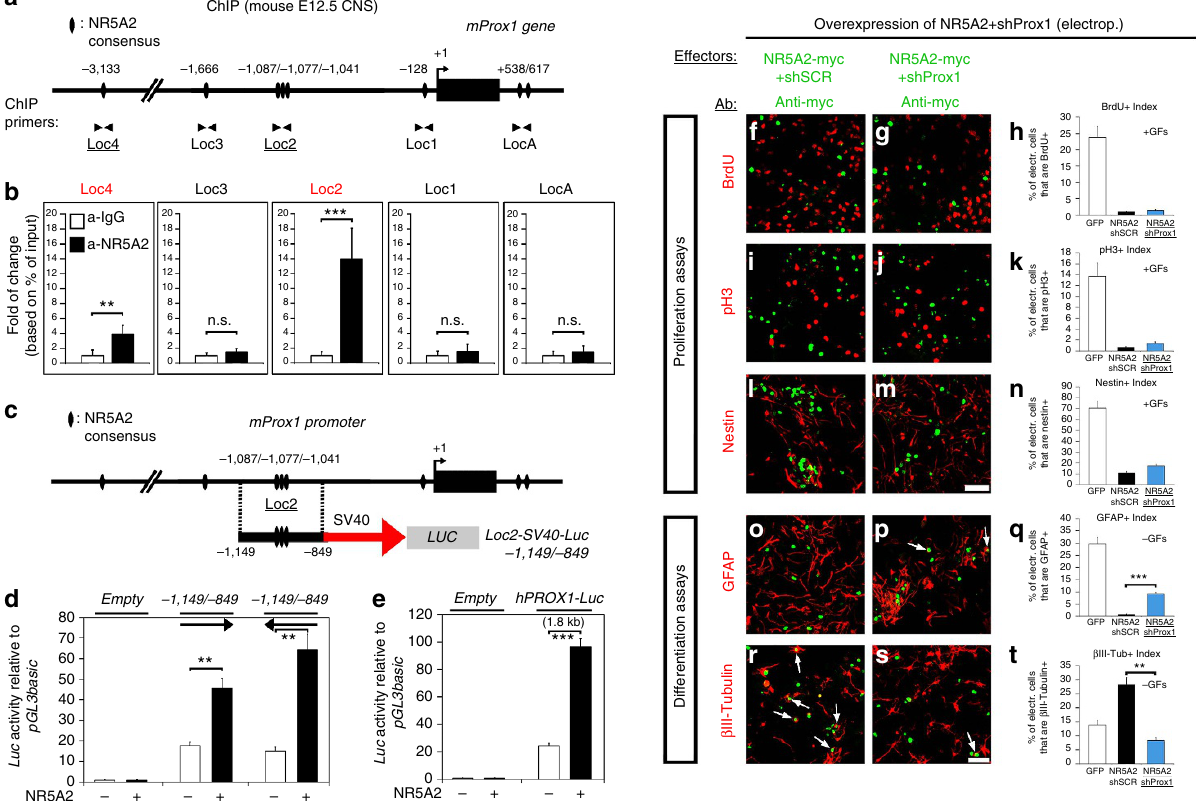
Figure 7 | NR5A2 regulates Prox1 expression via direct activation of Prox1 promoter. ( a ) Schematic representation of mouse Prox1 gene locus. ( b ) ChIP analysis for the binding of NR5A2 to Prox1 gene in chromatin prepared from the CNS of E12.5 mouse embryos. ( c ) Schematic representation of the luciferase-reporter constructs containing the mouse DNA sequence of Loc2 ( (cid:2) 1,149/ (cid:2) 849) in both orientations ( Loc2-SV40-Luc ( (cid:2) 1,149/ (cid:2) 849 ) - / ’ ). ( d , e ) Transcriptional assays in N2A neuroblastoma cells with mouse ( d ) or human ( e ) Prox1 promoter constructs, as indicated. ( f – t ) Double immunostainings of myc (green) with various markers (red) in NSCs co-electroporated with NR5A2-myc þ shSCR ( f , i , l , o and r ) or NR5A2-myc þ shProx1 ( g , j , m , p and s ) expression vectors, respectively. Arrows indicate representative NR5A2-myc þ cells that co-express GFAP ( o , p ) or b III-Tubulin ( r , s ). Quantifications of the indices of all markers are shown in h , k , n , q and t (% of GFP þ or NR5A2-myc þ shSCR þ or NR5A2-myc þ shProx1 þ ; marker þ /total GFP þ or NR5A2-myc þ shSCR þ or NR5A2-myc þ shProx1 þ ). The results are shown as mean ± s.d. NS, not significant. P 4